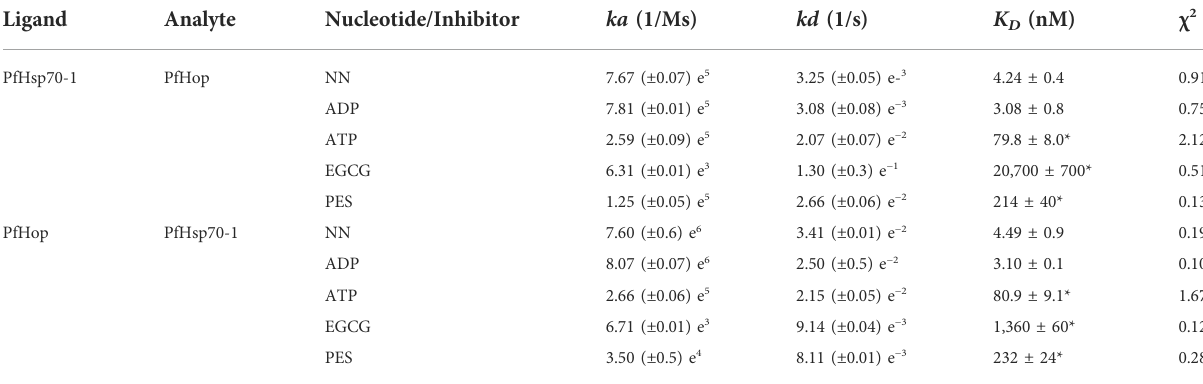
TABLE 4 SPR based kinetics showing the effect of PES on the interaction of PfHsp70-1 with PfHop. Ligand